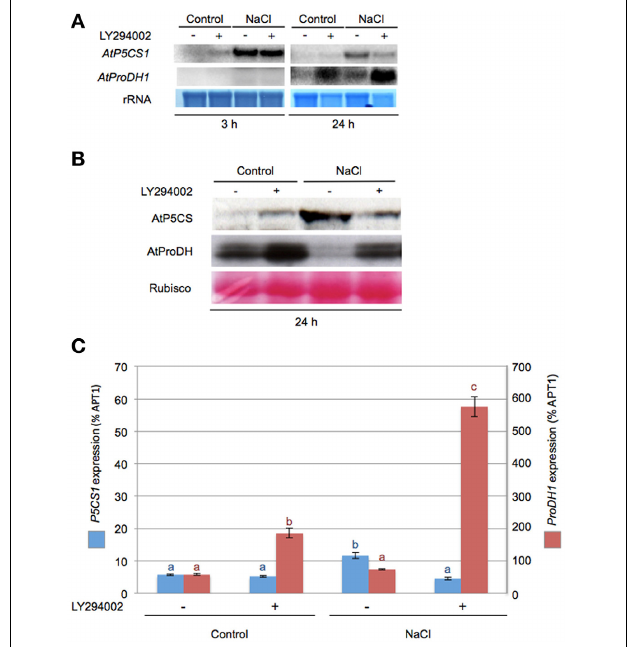
FIGURE 3 | LY294002 impacts ProDH1 steady state transcript and proteins levels. Northern- and western blot analysis were performed on total RNA or proteins extracted, respectively, from 12-days-old seedlings treated with either 0.5 × MS alone (control) or supplemented with 200mM NaCl (NaCl) during 3h or 24h with 100 µ M LY294002 ( + ) or DMSO ( − ) as described in the legend of Figure 1 . (A) Total RNA (10 µ g) was loaded in each lane and northern blots were probed with DNA fragments specific for AtP5CS1 and AtProDH1 . Methylene blue staining of rRNAs is shown as a loading control. (B) Total proteins (20 µ g) were separated on an 8% SDS-PAGE gel. Western blots were incubated with specific antibodies directed against AtP5CS and AtProDH proteins. Detection of the immunolabeled proteins was done by autoradiography using an ECL kit. Membranes were stained with Ponceau S Red as control for protein loading (Rubisco). (C) Relative expression levels of P5CS1 and ProDH1 genes measured by real-time quantitative PCR after 24h treatment as described in (A) . Results expressed as percentage compared to APT1 as a reference gene are means ± SD of 3 replicates. Letters indicate statistical differences in P5CS1 (blue letter) or ProDH1 (red letter) gene expression depending on treatment conditions (Two-Way ANOVA test, P < 0 . 05). The results presented in (A,C) were obtained from two independent